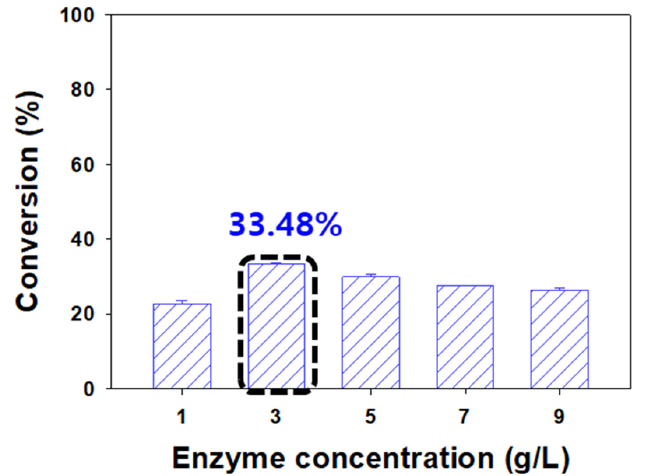
Figure 4. Effect of enzyme concentration. (Lipozyme TL IM, vinyl acetate as the acyl donor, 1:1 molar ratio of naringin to acyl donor, reaction temperature of 40 °C, tert -amyl alcohol as the solvent, and reaction time of 48 h).